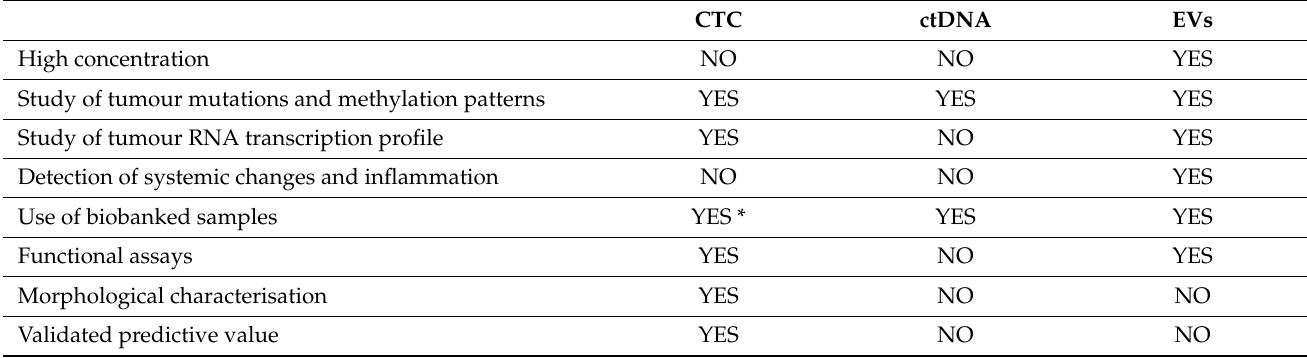
Table 2. Summary of the advantages and disadvantages of different circulating tumour entities (ctDNA, CTCs, EVs). (ctDNA: circulating tumour DNA, CTC: circulating tumour cells, EVs: extracellular